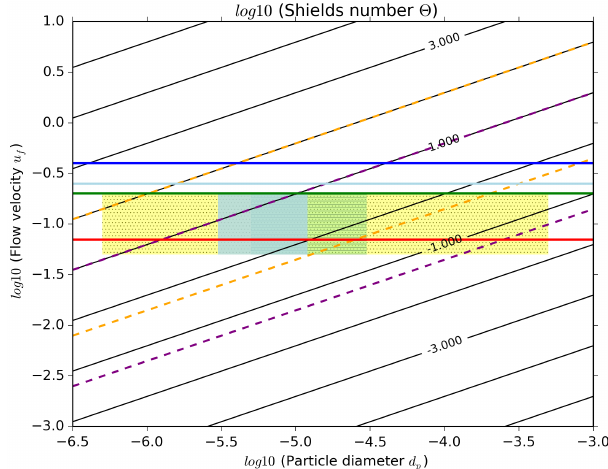
Figure 2. Contour plot of the settling velocity of particles ( u s in ms − 1 ) as a function of particle diameter ( d p in m) and particle ex- cess density relative to water ( s = ( ρ p − ρ f ) /ρ f , dimensionless). The blue, green-striped, and yellow-dotted rectangles refer to particle properties that are common for Dutch, UK, and Australian DWDSs (see Table 2 and the text for explanation). The black contour lines refer to particle settling velocity values. The blue line refers to the default particle settling velocity of u s = 1.6 × 10 − 6 ms − 1 deter- mined from experiments of the Australian DWDS.